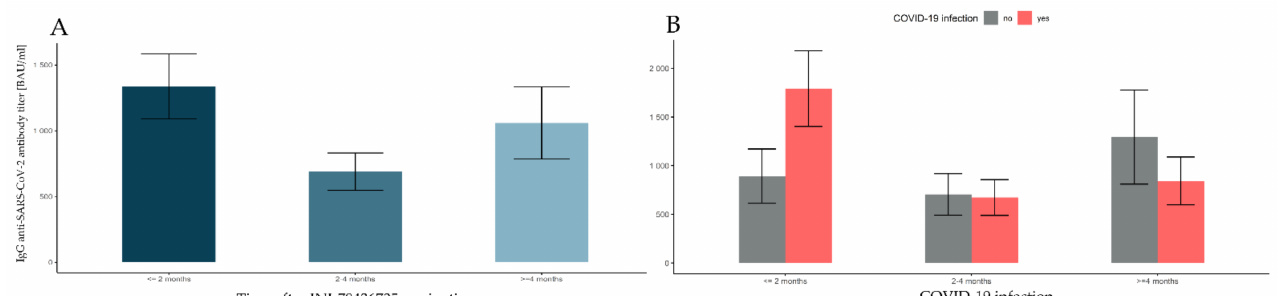
Figure 7. Comparisons of antibody levels following full vaccination with JNJ-78436735, taking into account the time factor and the incidence of SARS-CoV-2 infection. The error bars for marginal means with 95% confidence intervals (bootstrapped) are presented in turn: ( A ) the time elapsed after the full JNJ-78436735 vaccination; ( B ) prior COVID-19 infection grouped with different time intervals elapsed after full JNJ-78436735